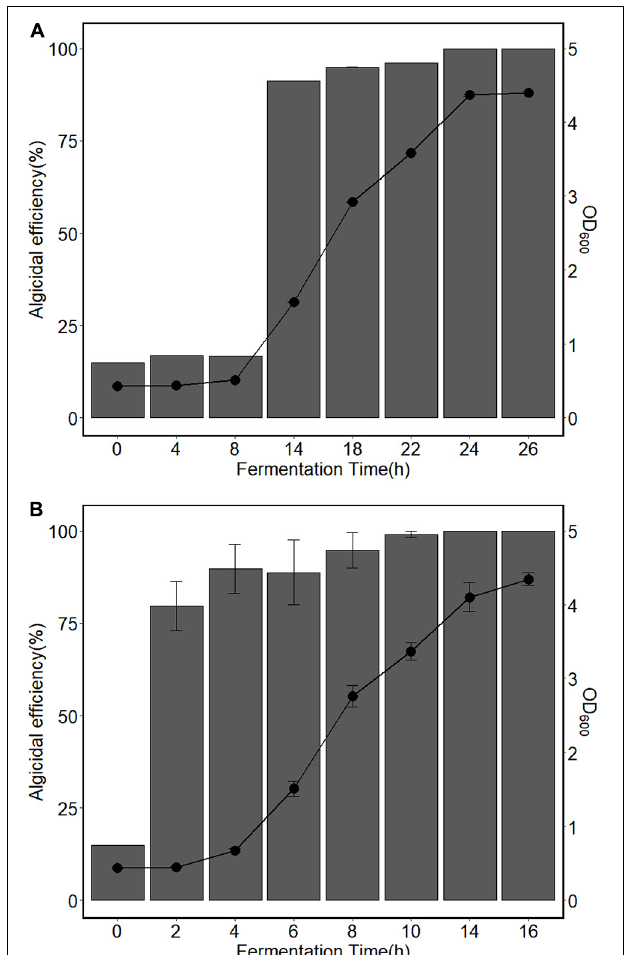
FIGURE 1 | Cell concentrations of H115 in fermentation broth and algicidal efficiency of cell-free fermentation broth during (A) initial fermentation and (B) repeated batch fermentation. Data for panel (B) was generated from the average of all three repeated batch fermentations. Bars represent the algicidal efficiencies and as indicated on the left y-axis. Points represent OD 600 and as indicated on the right y-axis. Values are means ± s.e, n =